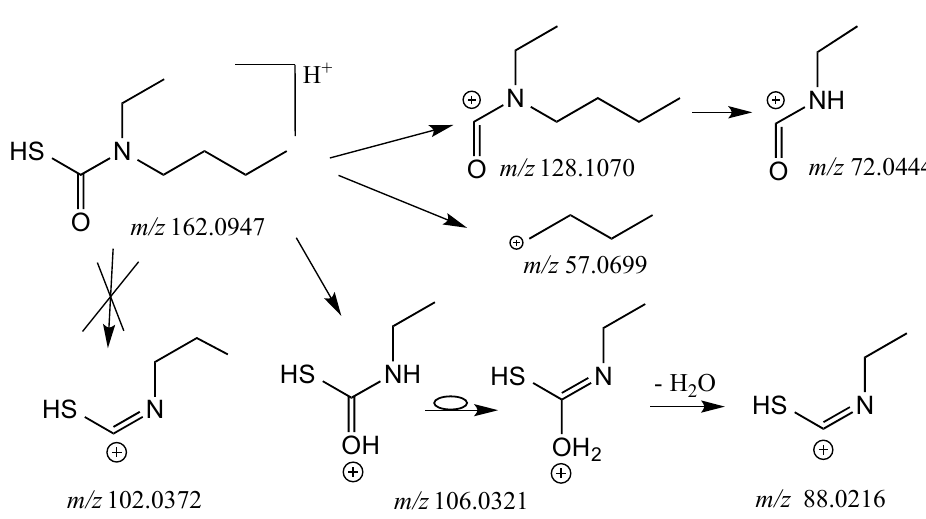
Scheme 2. Proposed fragmentation pathway for the CID generated product ion at m/z 162 of pebulate.